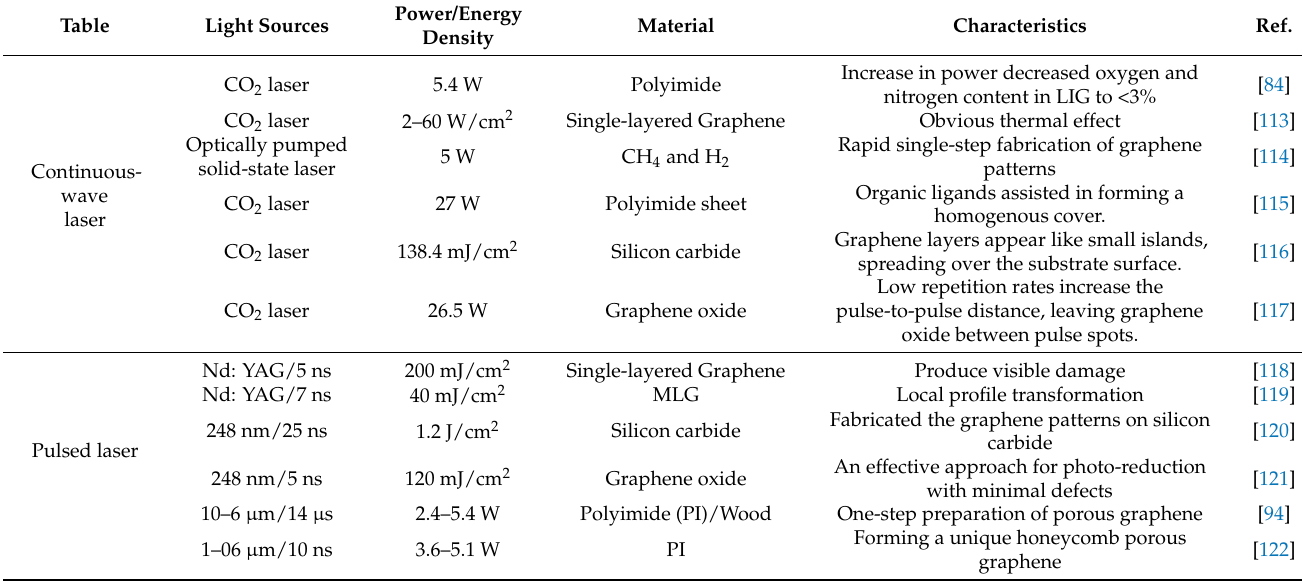
Table 1. Comparison of the power source and raw materials for the generation of different laser-induced graphene (LIG) outputs [78]. Copyright 2018 Taylor & Francis